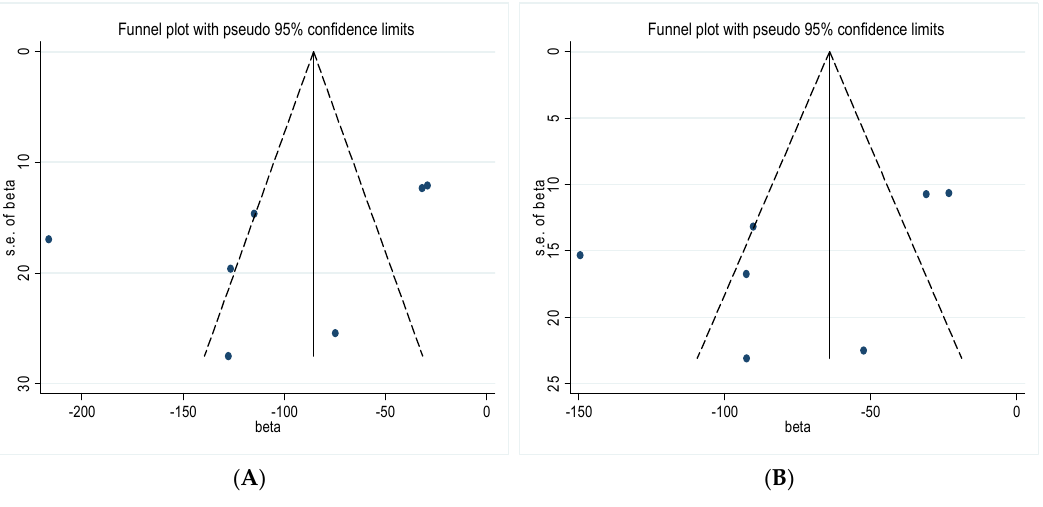
( D ) Figure 5. Funnel plot of the effects of PM 1 on lung function indicators in the long-term exposure group: ( A ) FVC, ( B ) FEV 1 , ( C ) PEF, ( D ) MMEF. 3.4. Sensitivity Analysis We performed the sensitivity analyses by using the leave-one-out method to assess the stability of the results. In short-term PM 1 exposure studies, results of the sensitivity analyses indicated that, with the exception of PEF group, the pooled effect estimates were not significantly affected by excluding each individual study (Figure 6). In long-term PM 1 exposure studies, results of the sensitivity analyses showed all pooled effect estimates were robust (Figure 7).